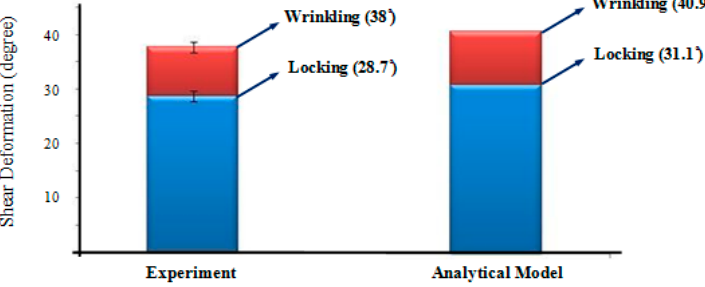
Figure 16. Experimental measurements of locking and wrinkling angles versus the predictions of the proposed analytical model (prediction error for (cid:2011) (cid:3030)(cid:3045) = 9.1%).